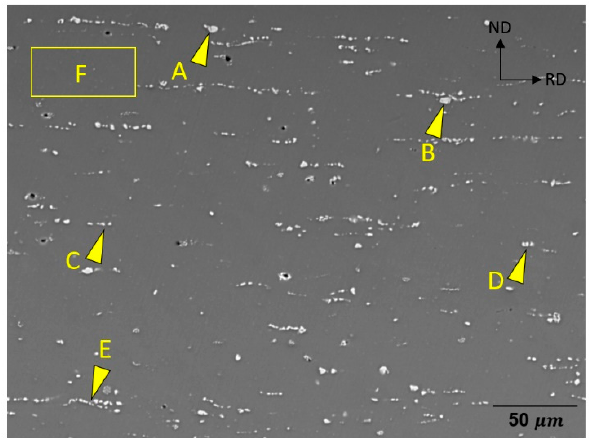
Figure 2. SEM image of homogenized ( a ) ZAXM2100 and ( b ) ZAXM4100 alloy sheets.